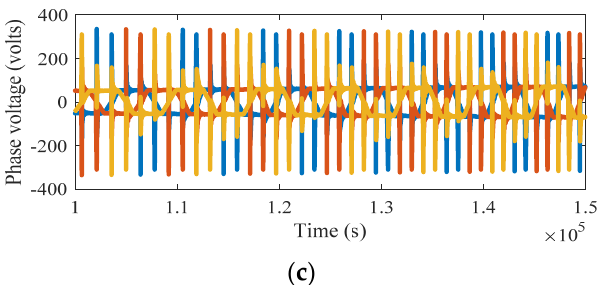
Figure 13. BLDC motor voltages and currents: ( a ) Line current vs Time ( b ) Line voltage vs Time and ( c ) Phase voltage vs Time.